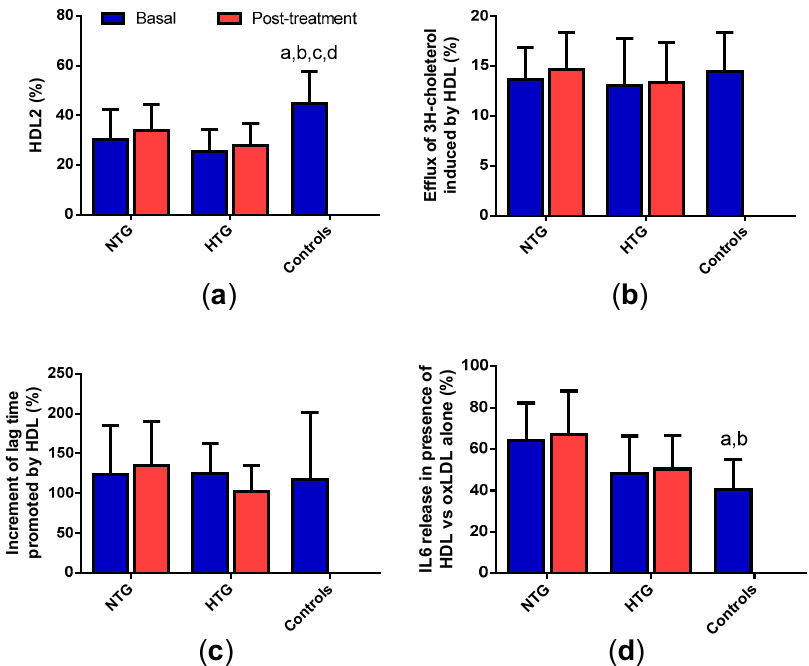
Figure 7. Qualitative properties of HDL. ( a ) HDL2 (large HDL particles) proportion was determined by GGE and expressed as the proportion of total HDL; ( b ) proportion of 3 H-cholesterol e ffl uxed by HDL from cholesterol-loaded macrophages; ( c ) increment of the lag phase time of the oxidation kinetics of a standard LDL induced by CuSO 4 in the presence of the HDL from each patient, expressed as percentage of lag time increase. ( d ) Proportion of IL-6 released from monocytes by oxidized LDL (oxLDL) in presence of HDL, compared with monocytes incubated with oxLDL alone (100% of IL-6 release). Data are expressed as mean ± SD. * p < 0.05 vs. basal samples. a p < 0.05 vs. basal NTG. b p < 0.05 vs.